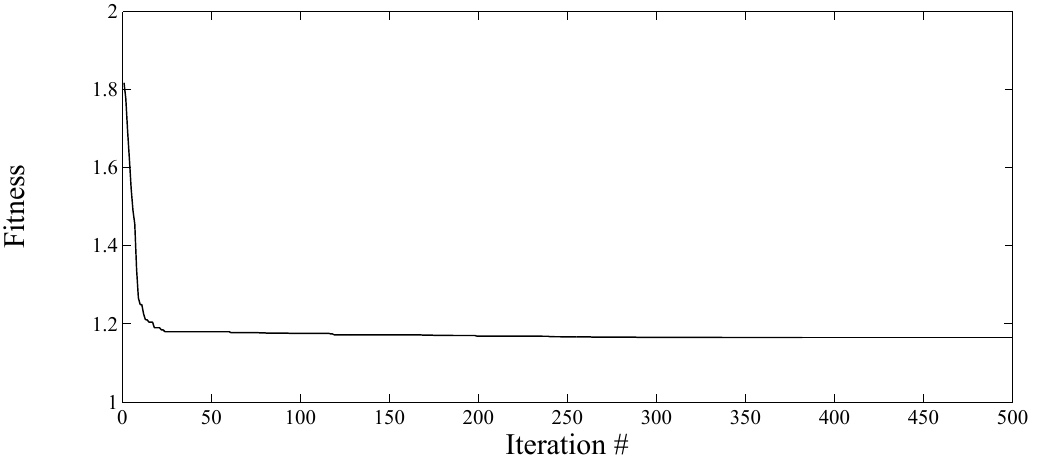
Figure 8. The global best particle’s fitness over the PSO